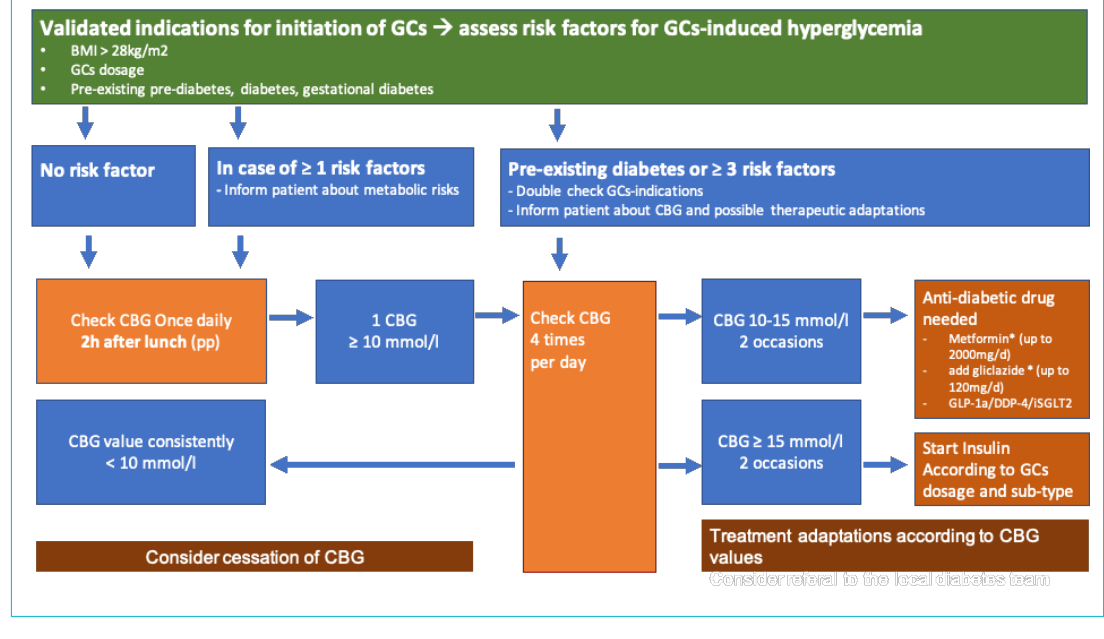
Figure 1: Risk of glucocorticoid-induced hyperglycaemia and treatment algorithm. CBG: capillary blood glucose; BMI: body mass index; pp: post-prandial; * start gliclazide and metformin only if renal clearance > 50 ml/min.